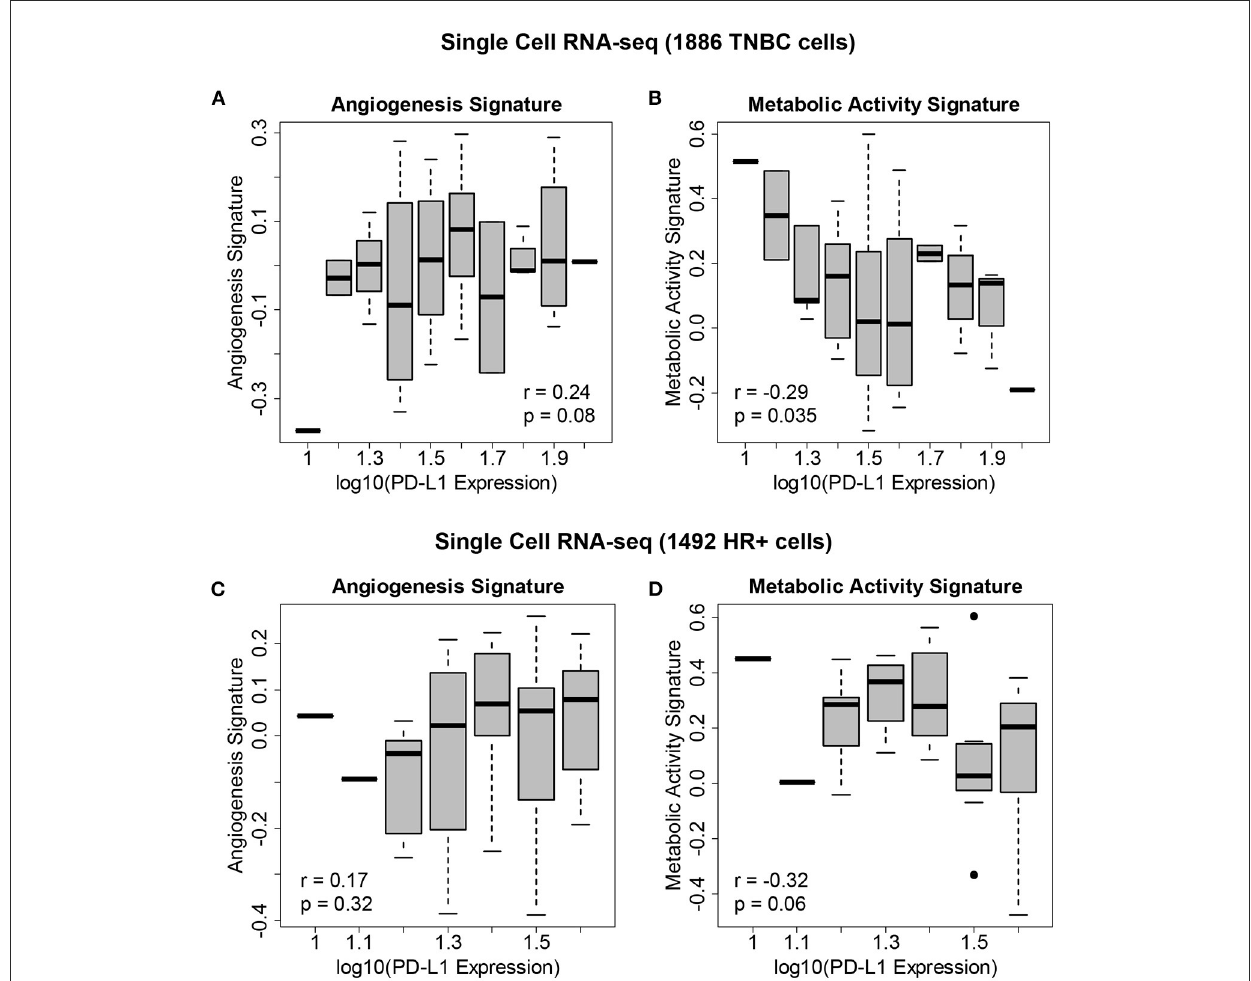
FIGURE4 Gene expression signatures associated with PD-L1 expression in single breast cancer cells. (A) Levels of the angiogenesis signature across 1,886 cells derived from eight TNBC patients vs. PD-L1 expression, showing an association between angiogenesis and PD-L1 levels. (B) Levels of the metabolic activity signature across these TNBC cells vs. PD-L1 expression, showing an association between metabolic activity and PD-L1 levels. (C) Levels of the angiogenesis signature across 1,492 cells derived from 9 HR /HER2- patients vs. PD-L1 expression. (D) Levels of the metabolic activity signature + across these HR /HER2- cells vs. PD-L1 +